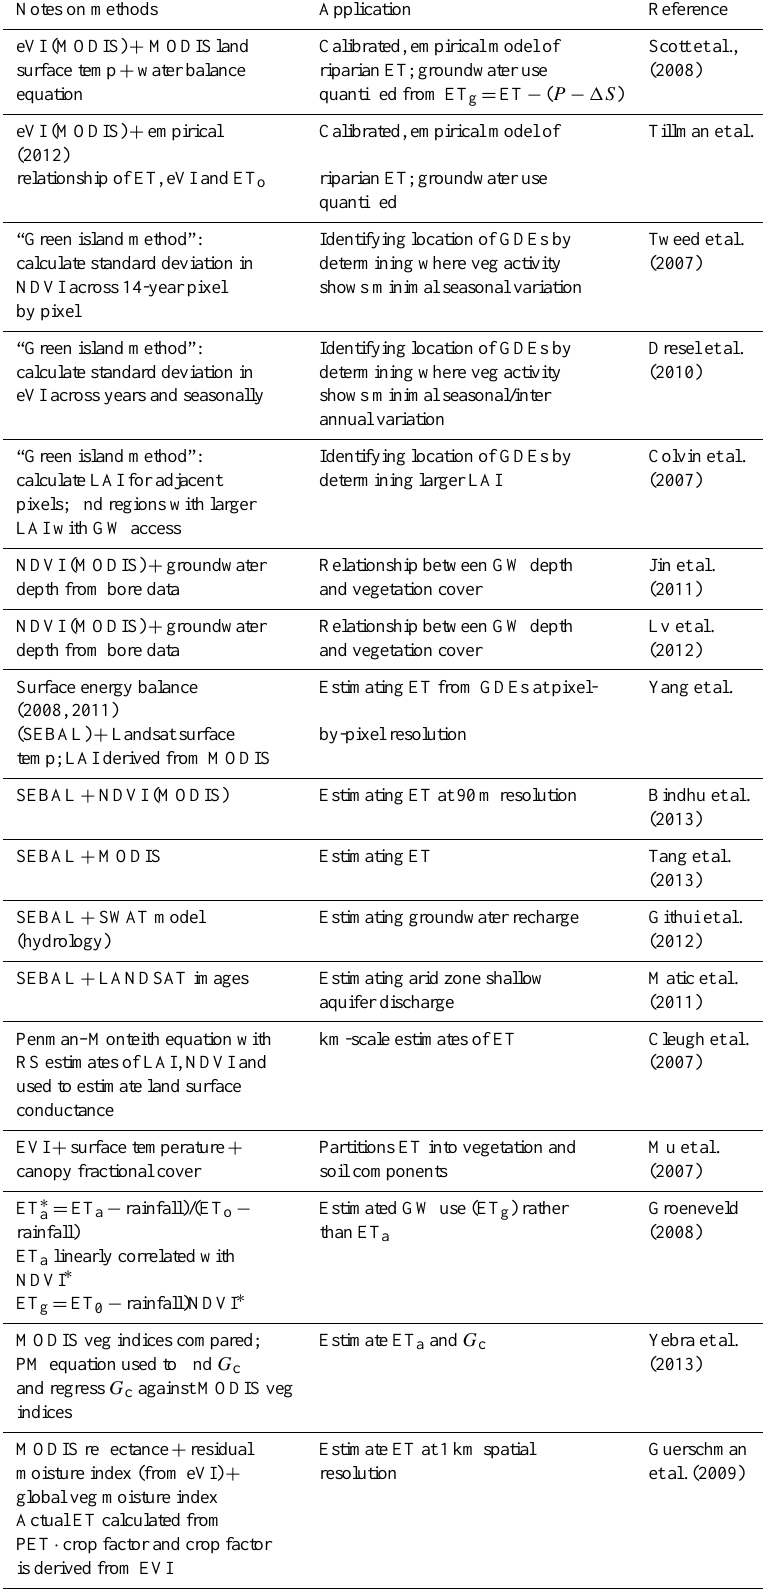
Table 2. Some examples of the application of remote sensing to the study of groundwater-dependent